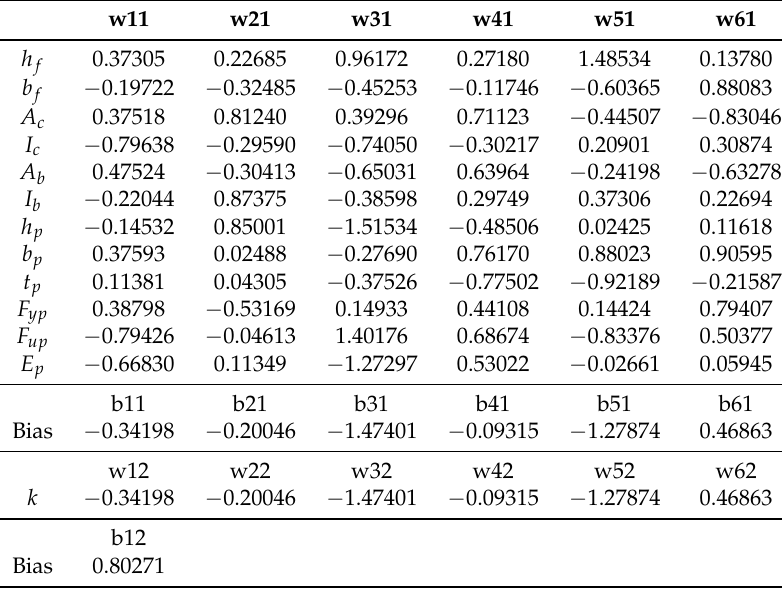
Table A4. Detailed meta-model for stiffness response of